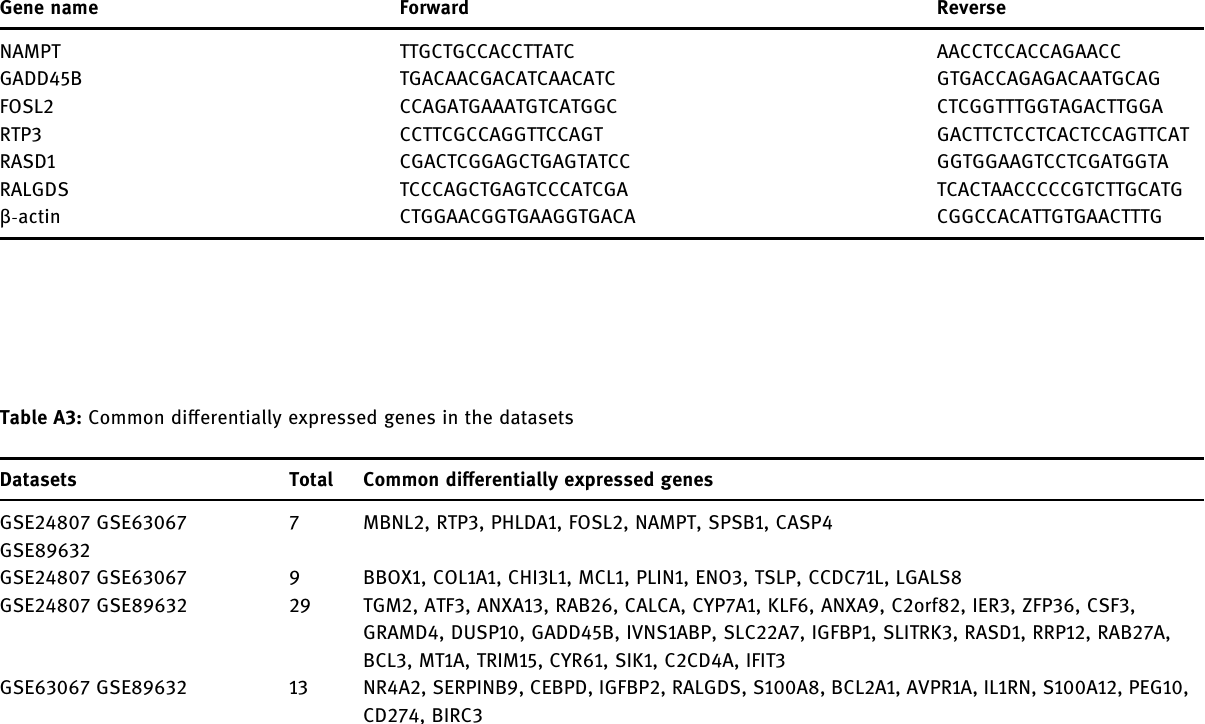
Table. A2: RT - PCR primers for mRNA expression measurements Gene